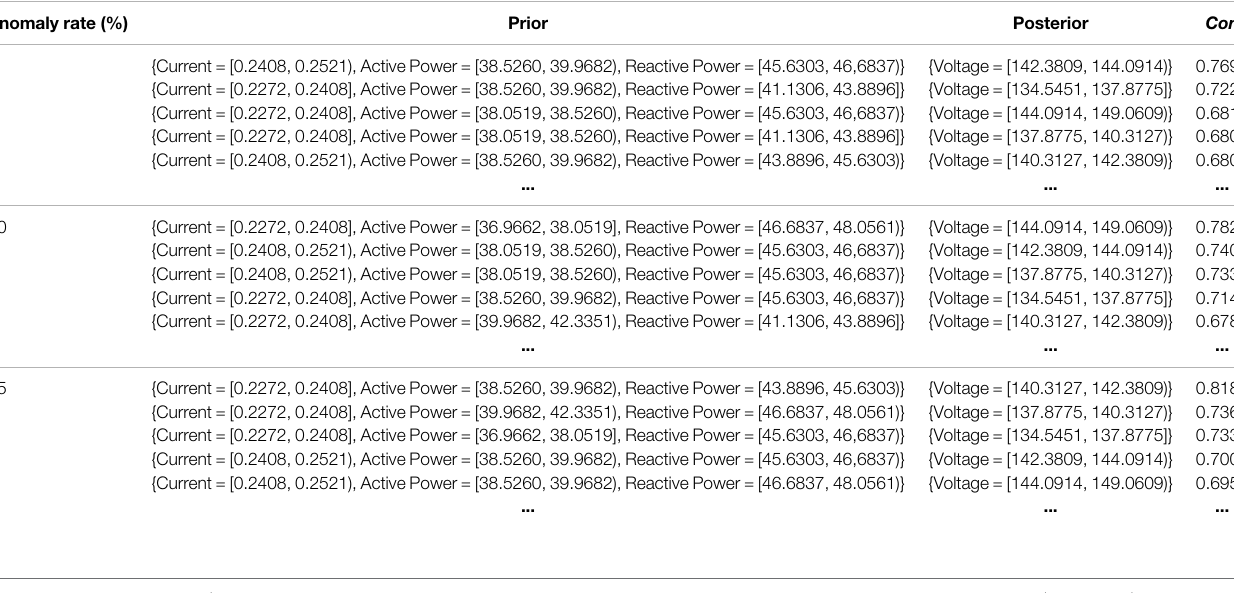
TABLE 3 | The part of association rules in different anomaly rate (voltage as posterior). Anomaly rate